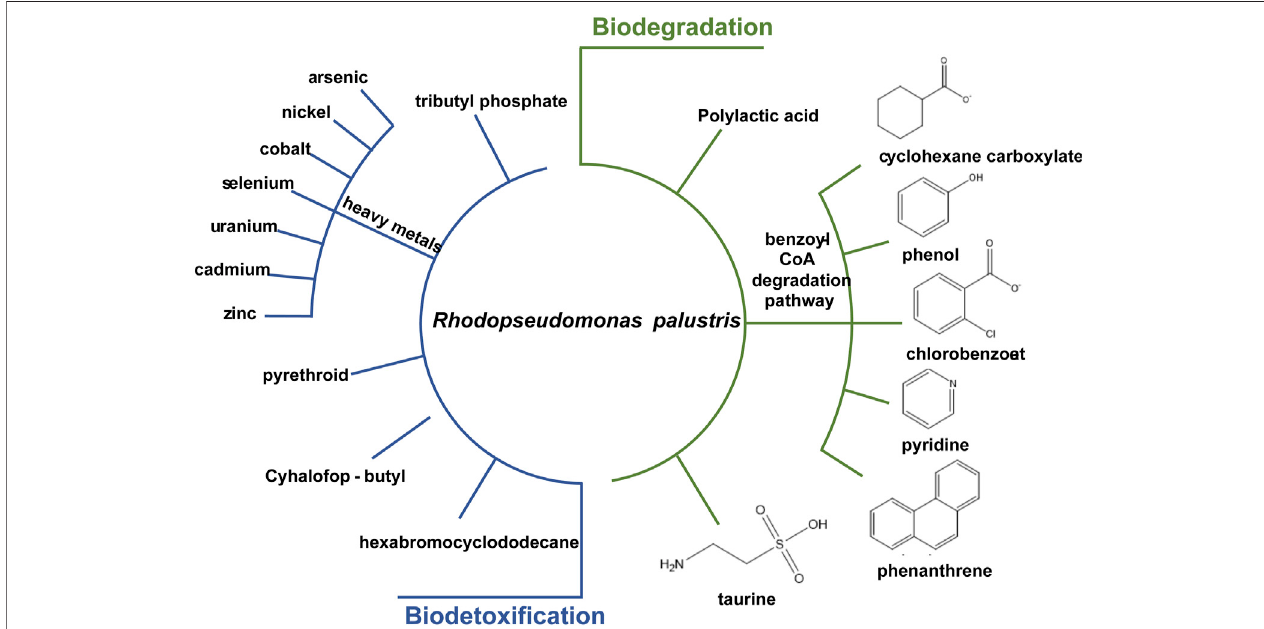
FIGURE 4 | Substrates which can be biodetoxi fi ed or biodegraded in R. palustris